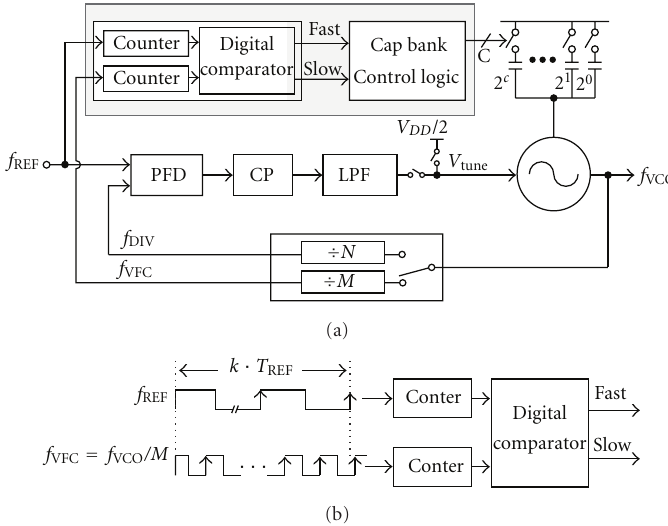
Figure 3: Relative frequency comparison VCO frequency calibration. (a) Architecture. (b) Operation principle [7, 8].